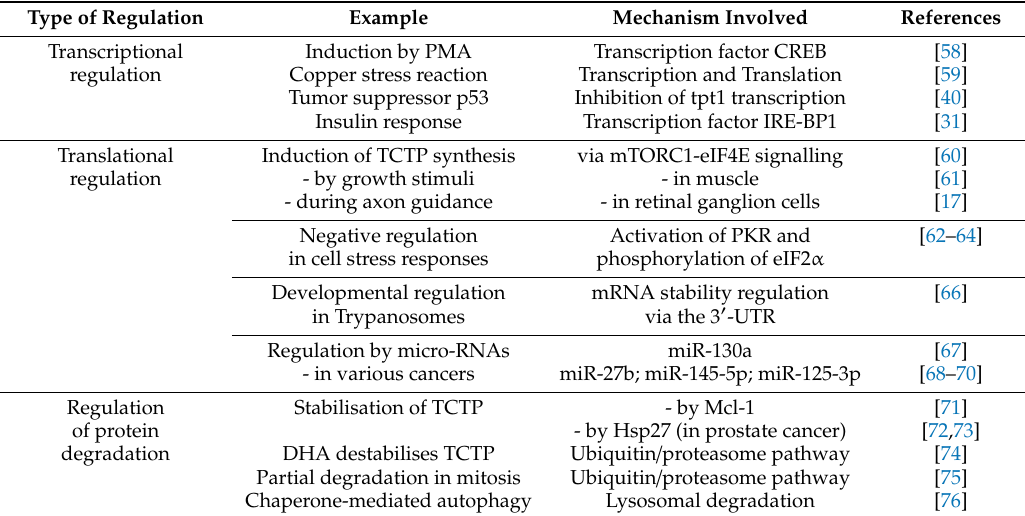
Table 2. Mechanisms involved in regulating cellular TCTP